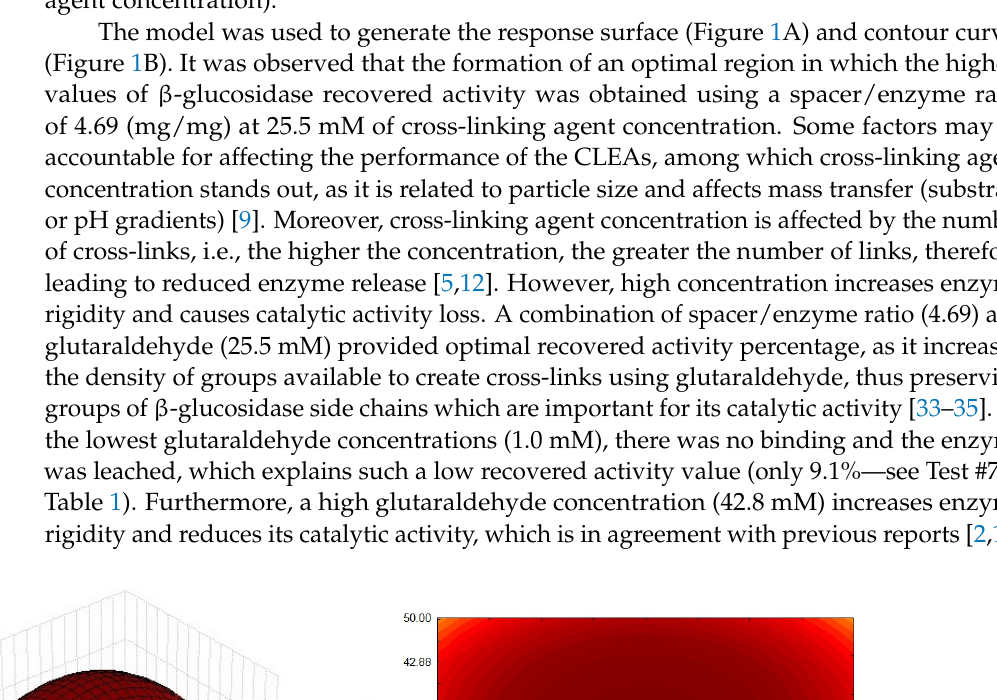
Figure 3. Effect of cross-linking time on β -glucosidase activity immobilized via the CLEAs technique (100% Relative activity corresponds to a hydrolytic activity of 1.48 U/mL). According to the results, a gradual increase in the recovered activity percentage by increasing cross-linking time was observed. This phenomenon is possibly due to insuffi- cient cross-links as reaction time was reduced, thus evidencing the leaching of free en- zyme molecules while washing protein aggregates [34,35]. The maximum recovered ac- tivity value around 33% was found at a cross-linking time ranging between 45 min and 60 min, followed by a slight decrease after 120 min. For longer reaction times, an excessive number of cross-links can provide a more rigid heterogeneous biocatalyst having smaller pores in addition to hindering substrate access to its microenvironment [9]. In fact, further tests using immobilized β -glucosidase were performed using the biocatalyst prepared af- ter 60 min of cross-linking time.